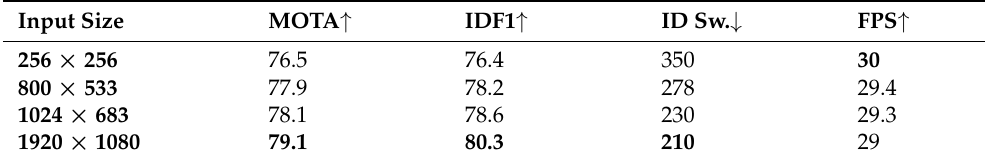
Table 2. Comparison of different resolutions on the validation set. The best results are shown in bold.